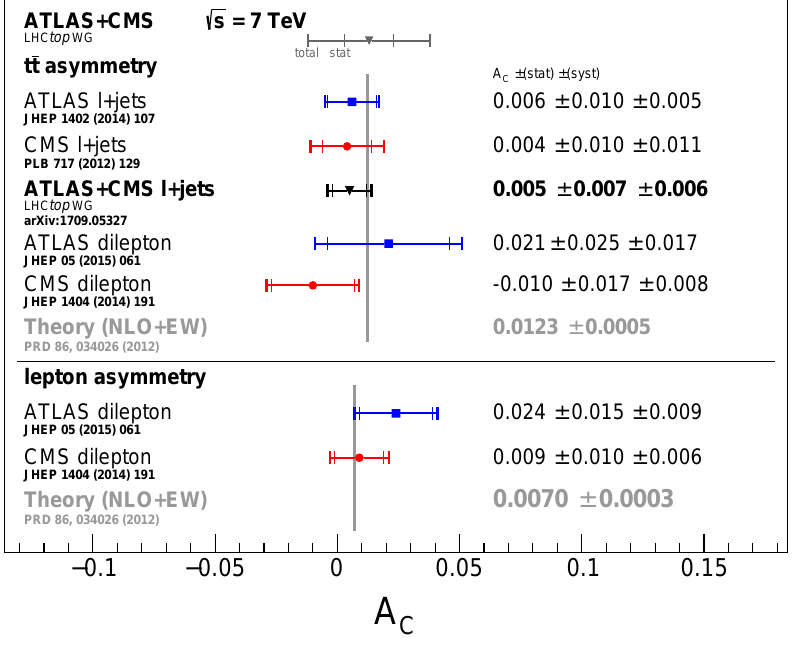
Figure 8. Summary of inclusive results at 7 TeV centre-of-mass energy